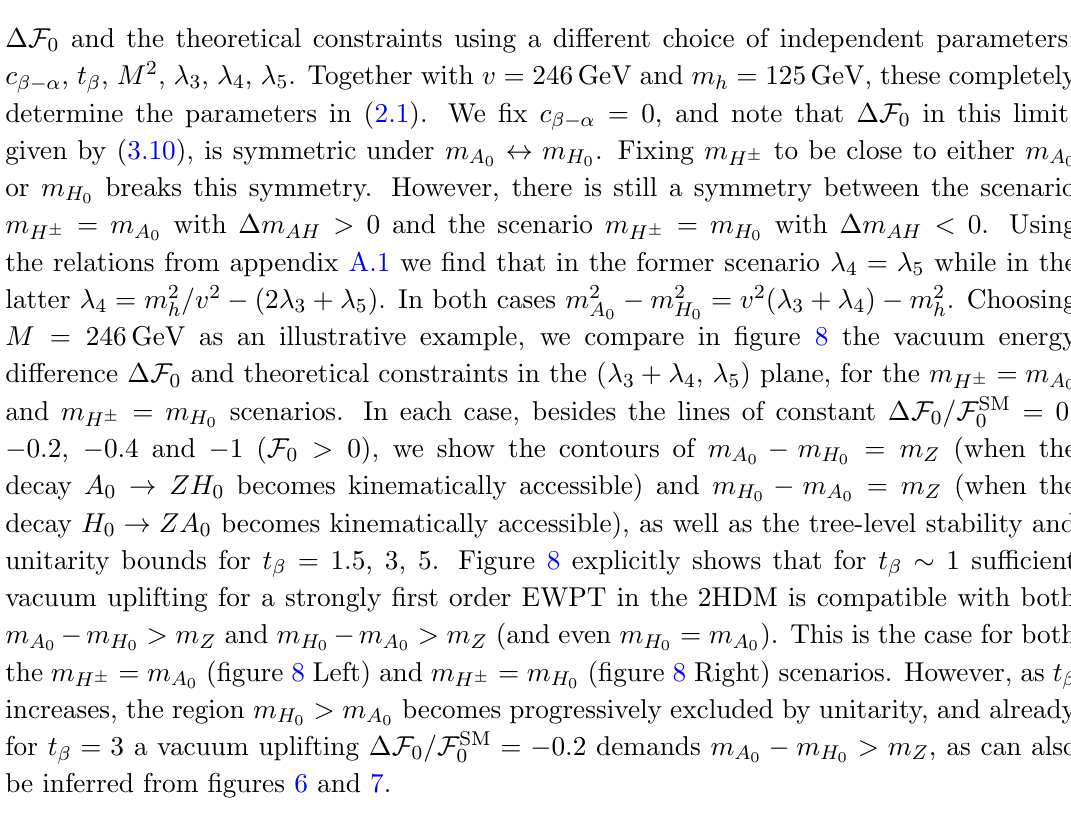
Figure 8 . (cid:21) 3 + (cid:21) 4 vs (cid:21) 5 for M = 246 GeV and assuming respectively m m H (Right). Red lines show constant values of (cid:1) 0 SM < (cid:1) = 1 ( > 0). Blue lines show the contours m A F 0 F (cid:0) F 0 m Z (dashed). The grey and orange regions are respectively excluded by boundedness from below of the scalar potential and by unitarity, for t (cid:12) = 1 : 5 ; 3 ; 5 (dark to light). The brown region is unphysical ( m H < 0 and/or m A < 0 0